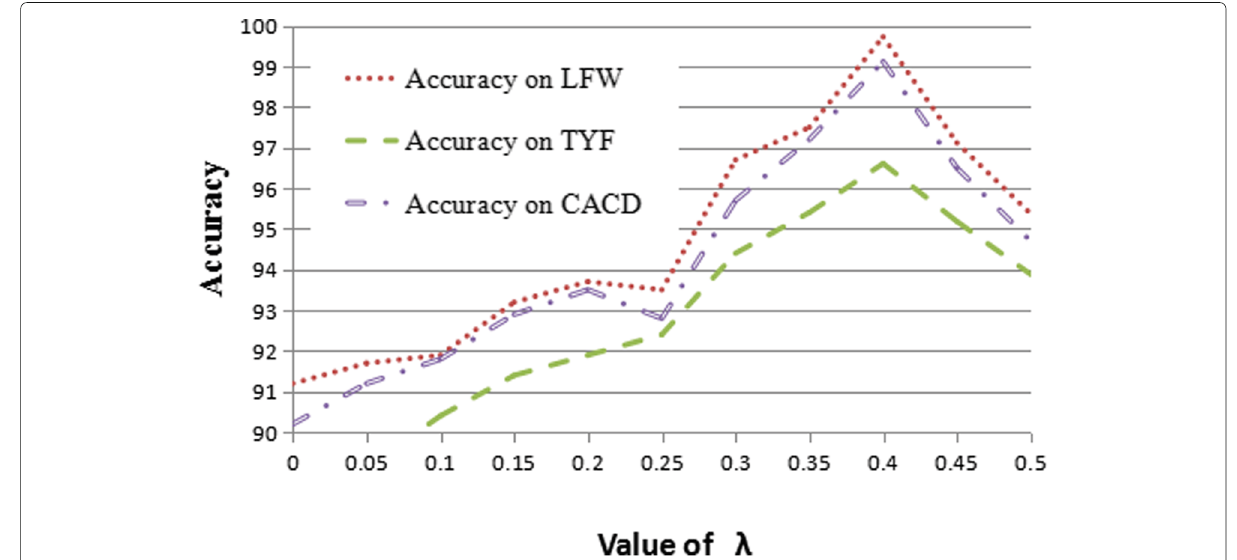
Fig. 3 Performance of the proposed method with different λ